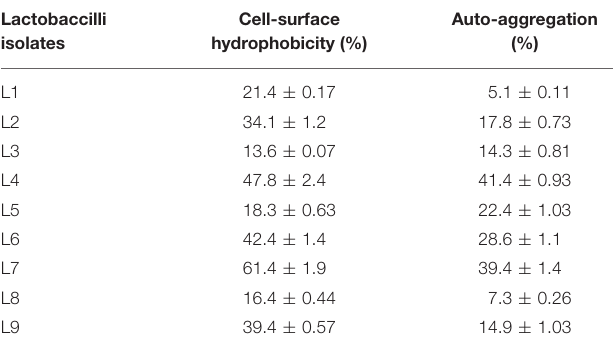
TABLE 2 | Assessment of cell-surface hydrophobicity (%) and auto-aggregation (%) activities of lactobacilli isolates as measured after 4h of incubation.